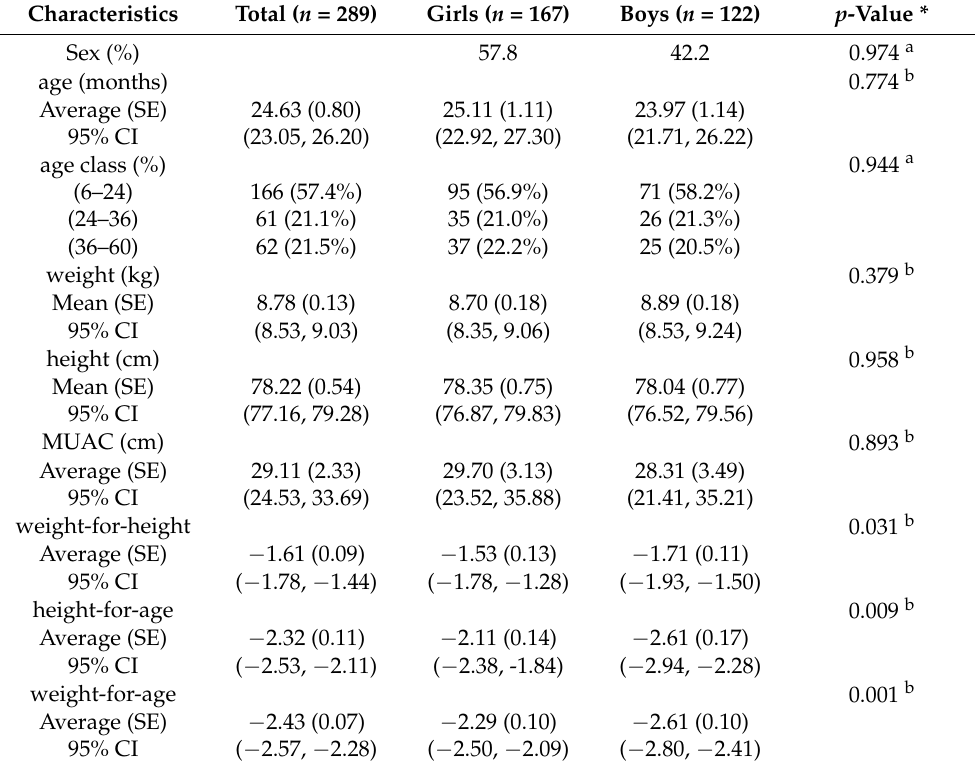
Table 2. Baseline characteristics of the MAM children participating in the LRN learning